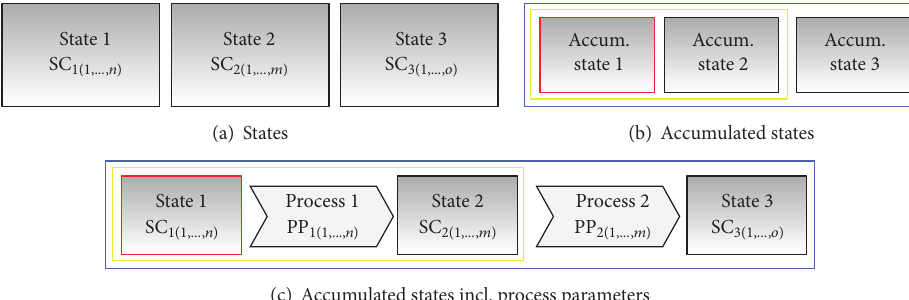
Figure8:(a)Three-statemodel.(b)Three-statemodelwithaccumulated states.(c)Three-statemodelwithaccumulatedparametersincluding process